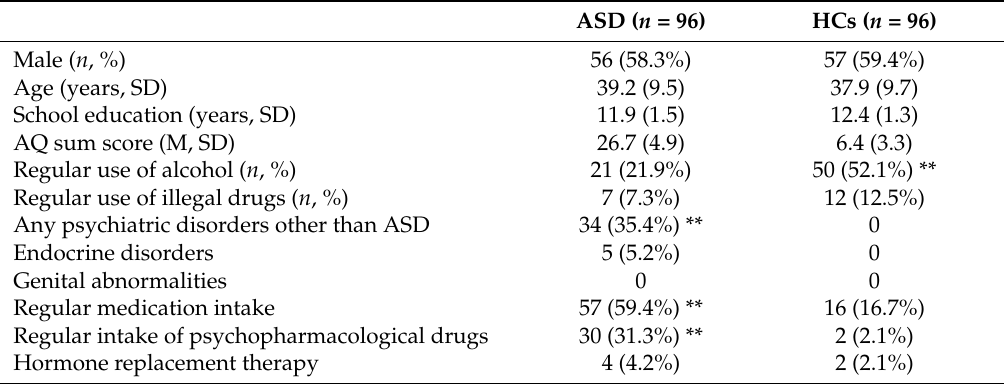
Table 1. Sociodemographic and clinical characteristics of study